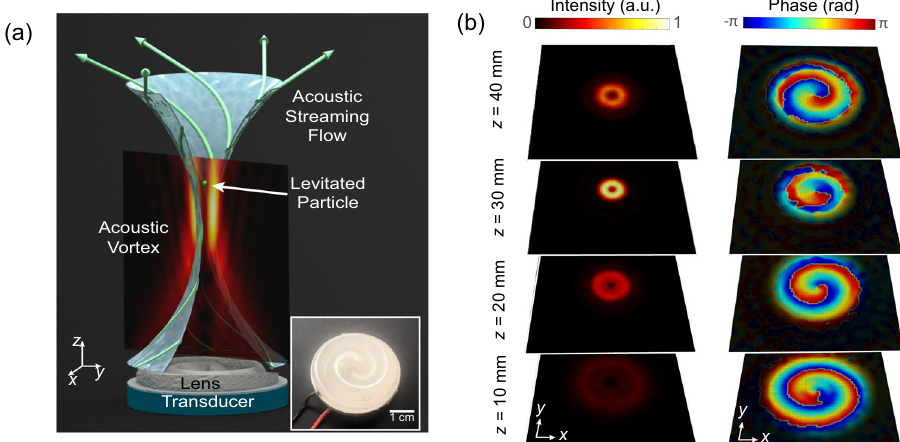
Fig. 1 Schematics of the design and working principle. a Creating a focused acoustic vortex for in-plane particle trapping, and the localized gradient streaming fi eld levitates the particle, providing trap in the third dimension. Inset shows a photo of the fabricated device. b Evolution of the intensity and phase fi elds across different cut planes along z axis. The fi eld is gradually focused as it propagates, keeping the spiral phase pro fi le in the